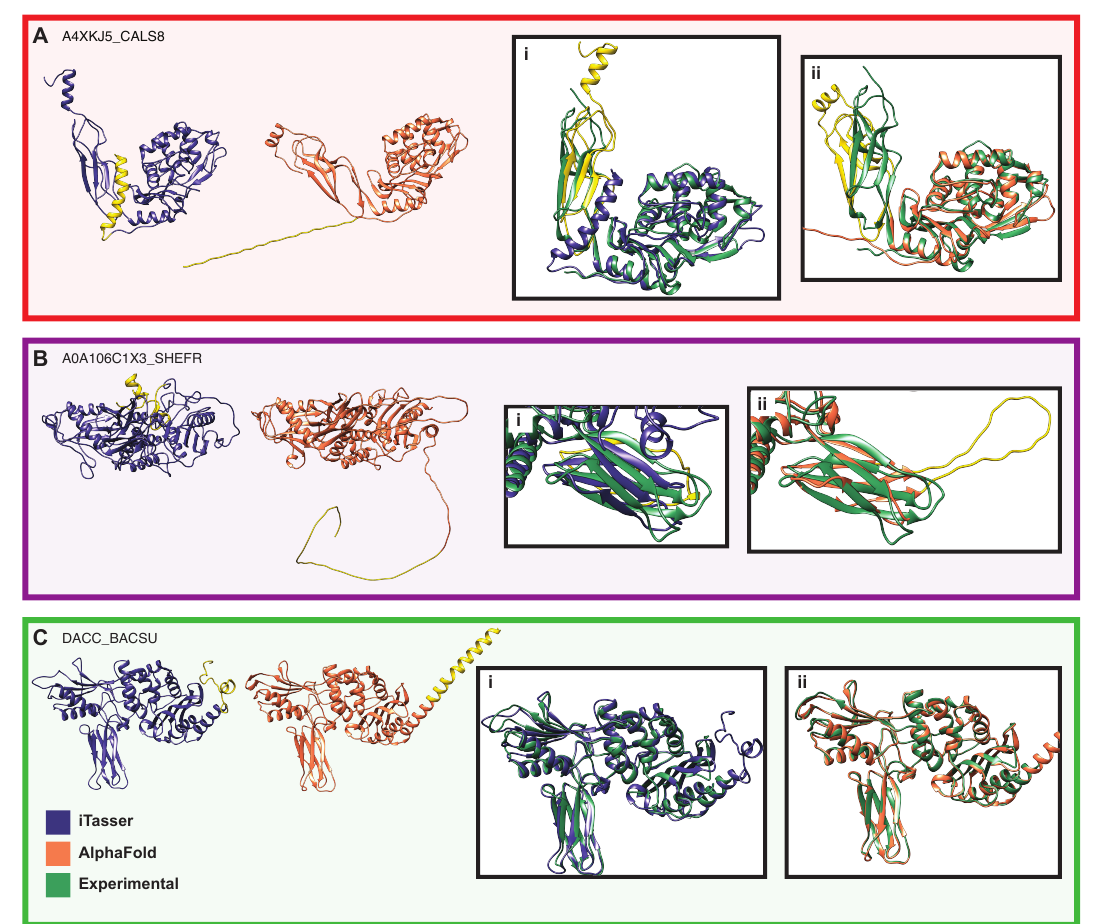
Figure 16. Comparisons between models produced by iTasser and AlphaFold. ( A ) The iTasser (blue) and AlphaFold (coral) models for A4XKJ5_CALS8 have similar folds for the catalytic domain and the C-terminal “tail” domain. However, the N-terminal signal sequence (yellow) is in the expected helical conformation in the iTasser structure and an unusual extended state in the AlphaFold structure. The insets i. and ii. show these structures overlaid with the crystal structure of a homolog (PDB ID: 4K91 [74]). The iTasser structure does better at reproducing the relative orientation of the two domains. ( B ) The iTasser (blue) and AlphaFold (coral) models for A0A106C1X3_SHEFR behave similarly to the ones in ( A ), but here the unfolded N-terminal region extends far beyond the signal sequence. The insets i. and ii. show a compact β -sheet region overlaid with the experimental structure of DACC_BACSU (see ( C )), which is also an S13 protease. In the iTasser structure, this small domain is compactly folded, while the AlphaFold structure predicts an unusual extended loop. ( C ) The iTasser (blue) and AlphaFold (coral) models for DACC_BACSU are both well-folded and compact. Neither exactly produces the expected α -helix for the signal sequence; in the iTasser structure, it is not fully helical, and in the AlphaFold model, the helix is much longer than is typical. Both models (i. and ii.) are in excellent overall agreement with an experimental crystal structure of this protein (green, PDBID: 2J9P [68]). The signal sequence is not present in the construct that was experimentally